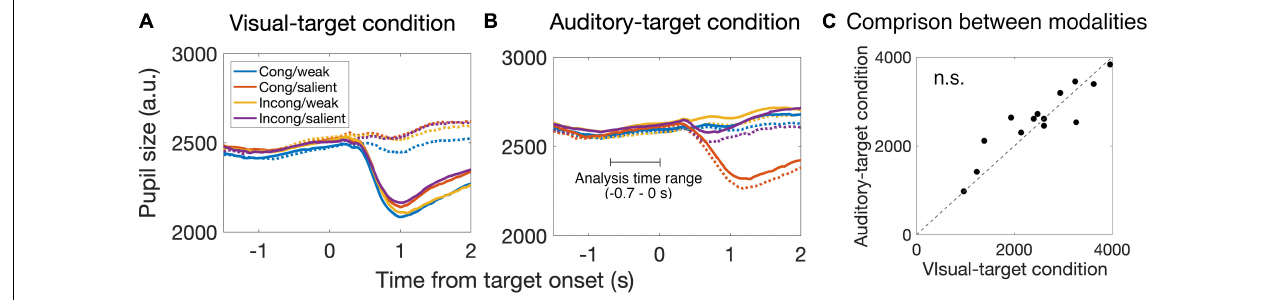
FIGURE 5 | Time course of pupil size change around the target onset for the visual-target condition (A) and the auditory-target condition (B) . Solid and dashed lines indicate the strong and weak targets, respectively. Each color indicates the combination of the spatial congruency and the saliency of non-target stimulus. We analyzed the pupil data from –0.7 to 0 s relative to the target onset to examine the saccade preparation effect on pupil size. (C) Comparison of pre-saccade absolute pupil size between visual and auditory tasks. We found no significant difference between them, suggesting that there is no effect of task demand (i.e., engagement in the visual task vs. auditory task) on mean pre-saccade absolute pupil size. Each dot indicates data for each participant.